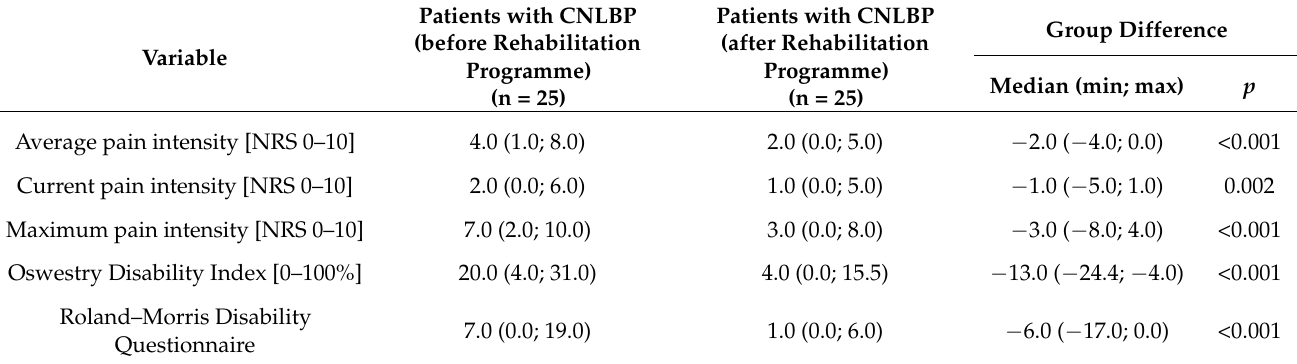
Table 4. Pain and disability—before and after rehabilitation programme.